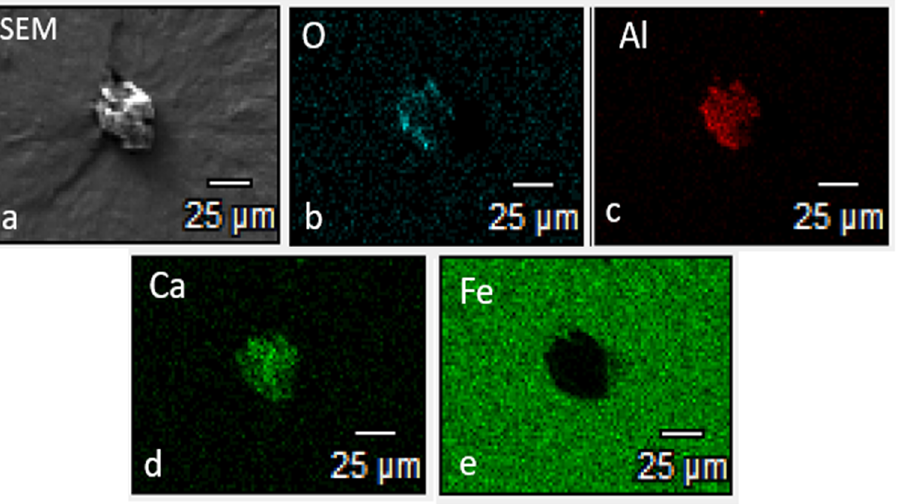
Figure 4. EDX mapping analysis of a crack-initiating inclusion. ( a ) SEM image; ( b ) O content; ( c ) Al content; ( d ) Ca content; ( e ) Fe content.